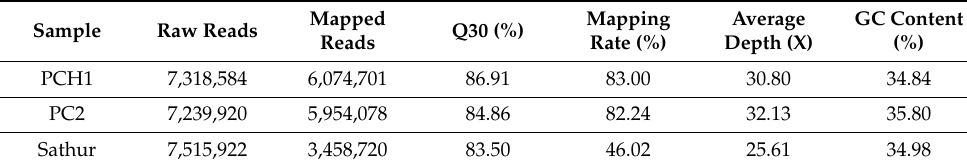
Table 3. Statistics of genotyping-by-sequencing data generated in this study.